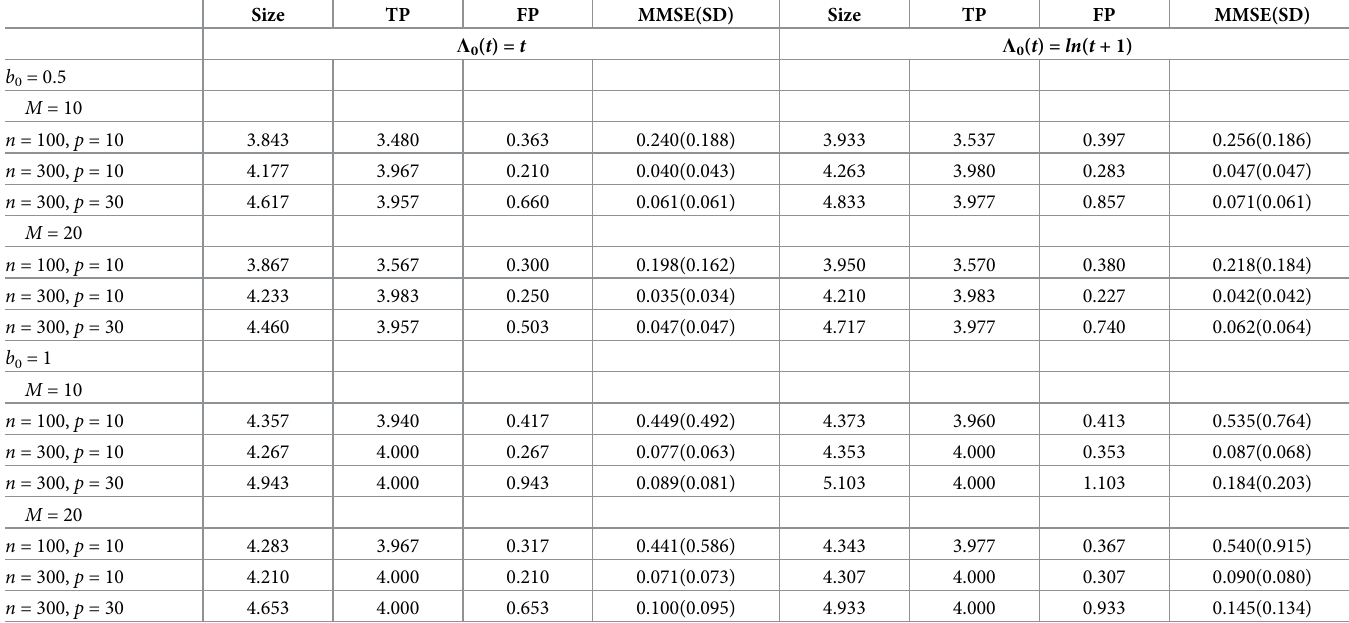
To comprehensively assess the performance of appIC, its estimation results were compared with other commonly used approaches to variable selection: LASSO, SCAD, MCP, and BAR under the most serious conditions above, that is M = 10 and b = 0.5. The parameters of these 0 penalties are tuned with 5-fold cross validation with the largest log-likelihood value on the vali- dation sets. The estimations with true covariates (oracle) and full models (without selecting the covariates) are presented alongside in Tables 6 and 7. The measurements are described in the previous paragraph. It is obvious that the appIC sparse estimation performs well in both Table 5. Comparison of different scenarios with the appIC model.